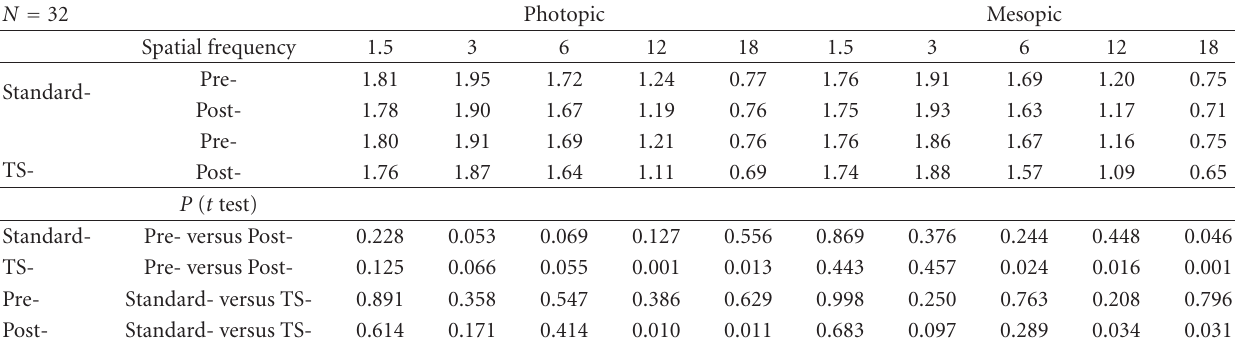
Table 4: Pre- and postoperative contrast sensitivity in Group 3 (sphere > − 6D) underwent tissue-saving LASIK or standard LASIK. N =